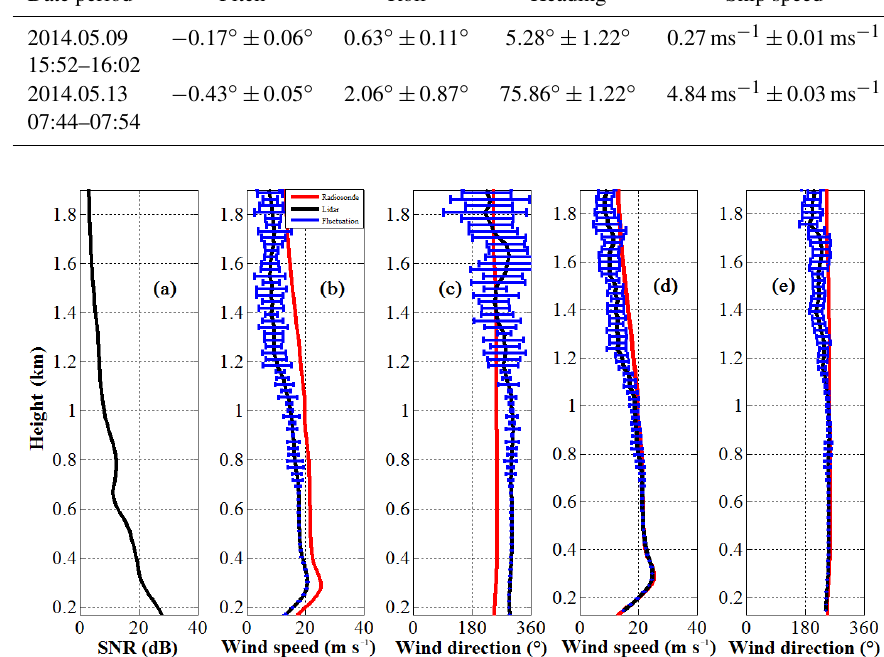
Figure 6. As Fig. 5, but for 07:44 to 07:54LT on 13 May 2014 in cruising observation.